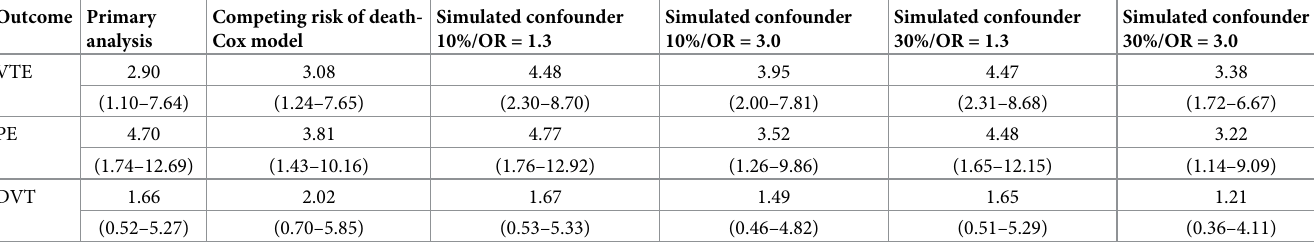
Table 4. Sensitivity analyses, HR (95%